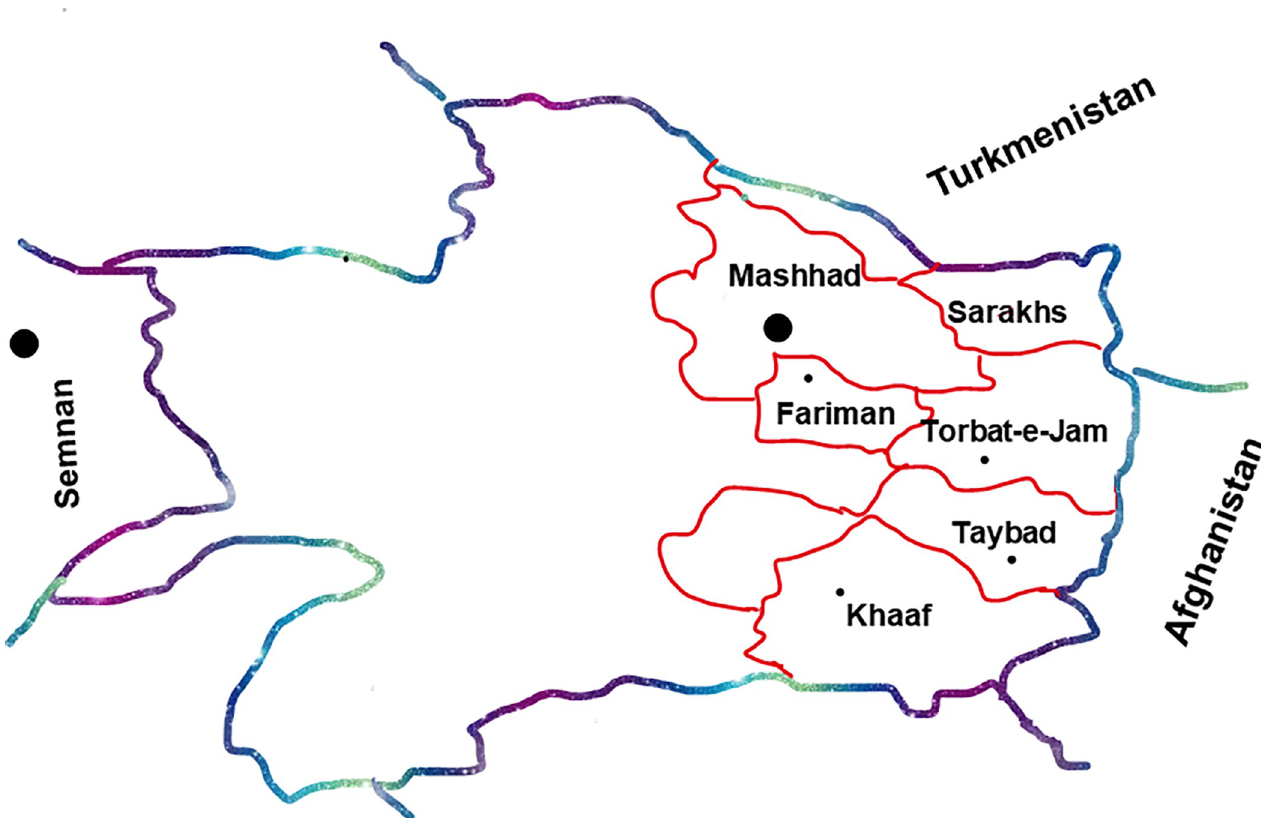
Fig 1. Birth place-based frequency of Afghans studies population. Eastern cities of Razavi Khorasan, the map shows the main locations of studied cities and the neighbourhoods. The Razavi Khorasan map was translated and depicted according to the National Cartographic Center of Iran; 2021, (https://www.ncc. gov.ir/images/docs/files/000005/nf00005286-2.pdf).